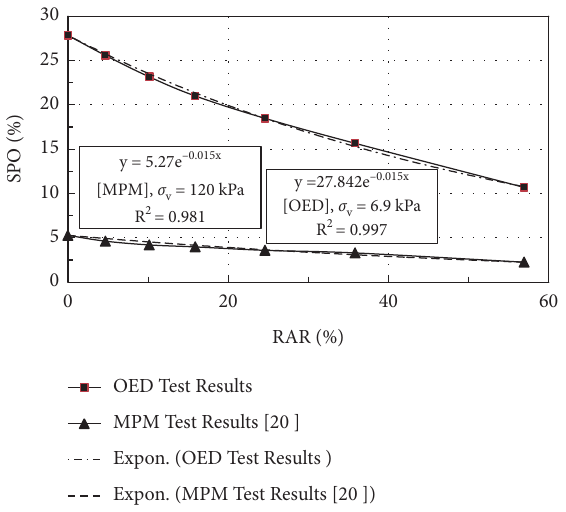
Figure 4: Variations of SPO with RAR for OED and MPM.